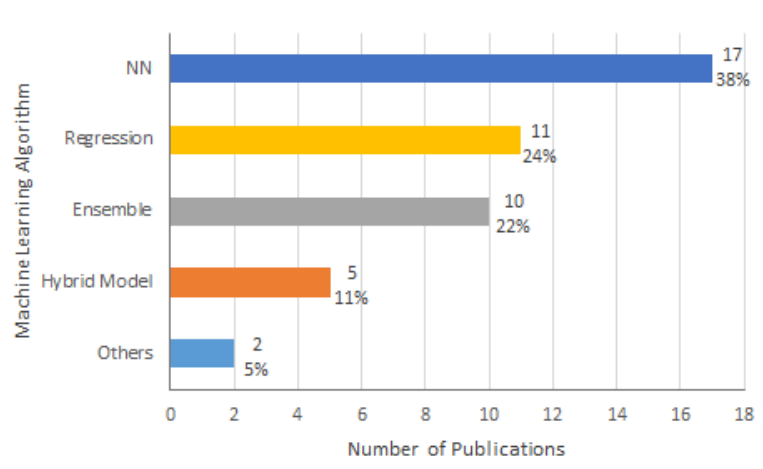
Figure 3. Case study of the publications.